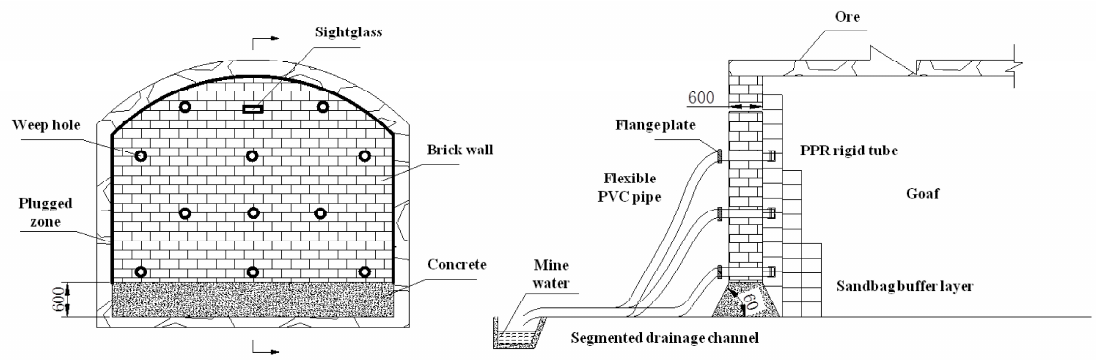
Figure 2. Diagram of filling retaining wall.